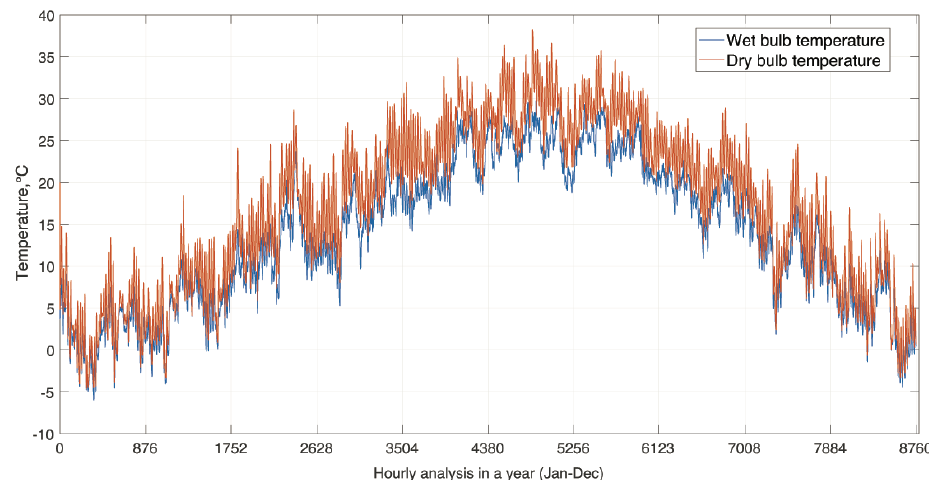
Figure 4. Suzhou’s typical meteorological-year temperatures.